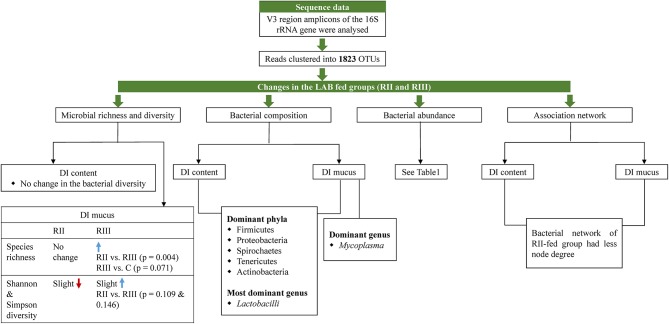
Illustration summarizing the salient observations of the study. DI, distal intestine; C, control group; RII and RIII, LAB-fed groups.